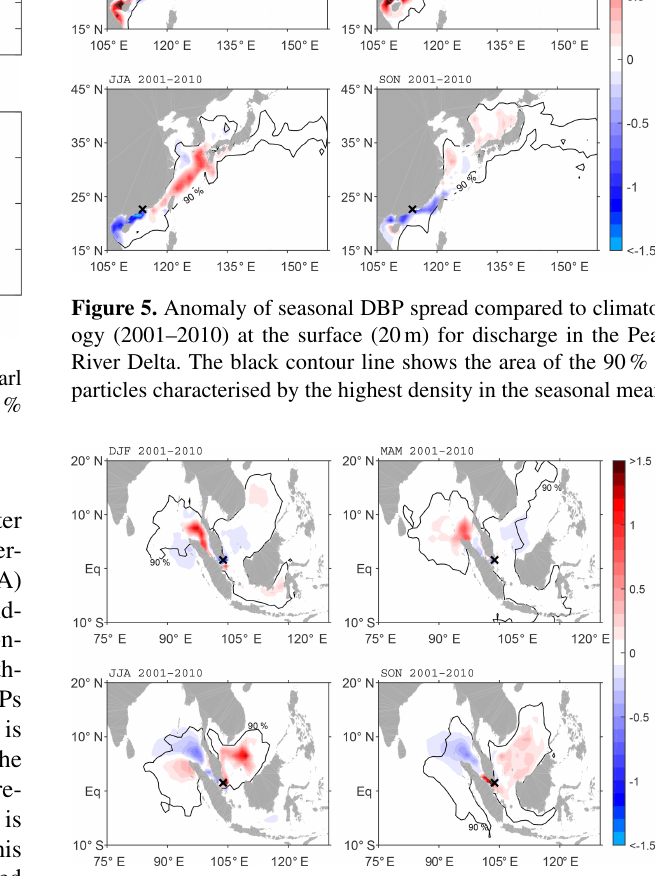
Figure 6. Anomaly of seasonal DBP spread compared to climatol- ogy (2001–2010) at the surface (20m) for discharge in Singapore. The black contour line shows the area of the 90% of particles char- acterised by the highest density in the seasonal